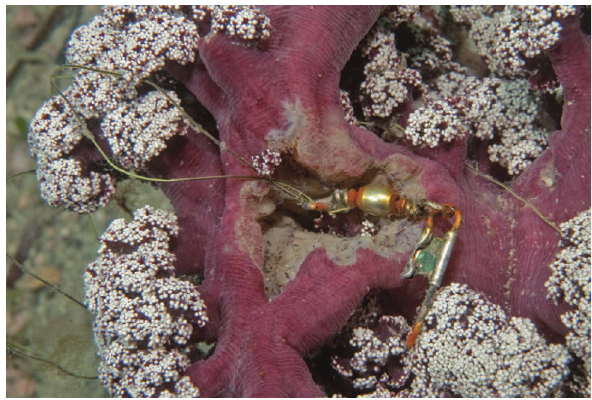
Figure 4. Direct impact of fishing activities on a colony of the geographically restricted soft coral Dendronephthyaaustralis at the Pipeline, Port Stephens.